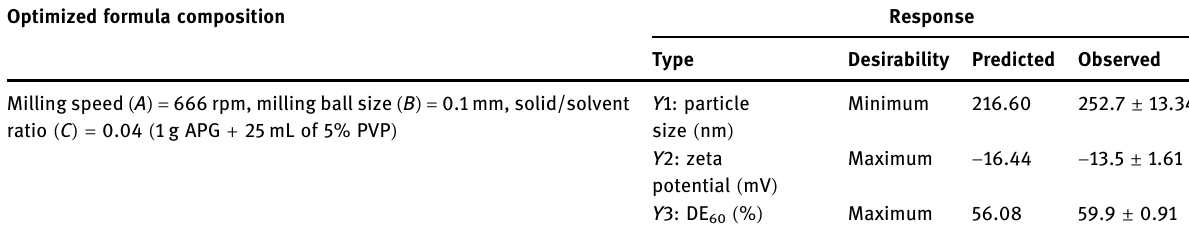
Table 6: Composition of the optimized APG nanoparticle formula, the desirability of responses and their observed and predicted values Optimized formula composition